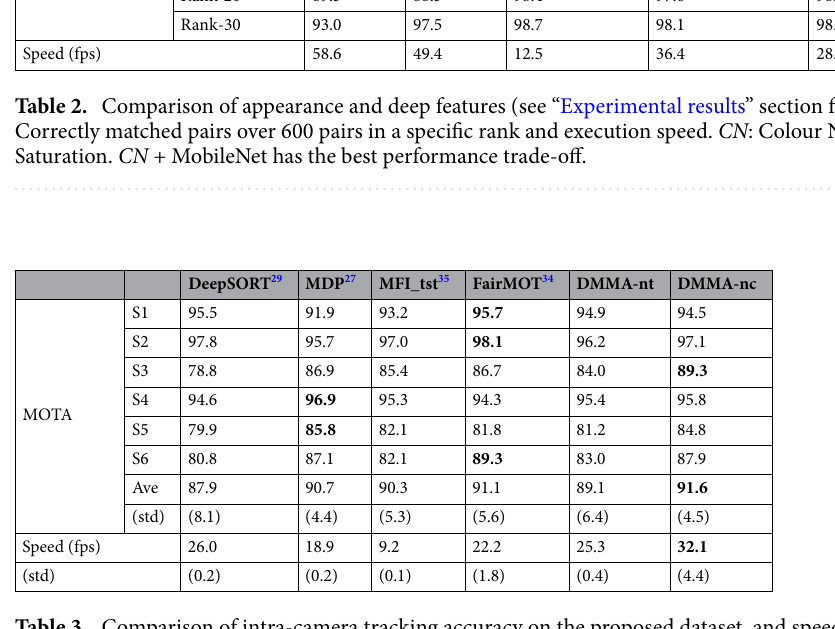
Table 3. Comparison of intra-camera tracking accuracy on the proposed dataset, and speed of detection and tracking combined. S, Scene; Ave (std), average of all scenes and (standard deviation); MOTA, Multiple Object Tracking Accuracy 58 ( bold : best